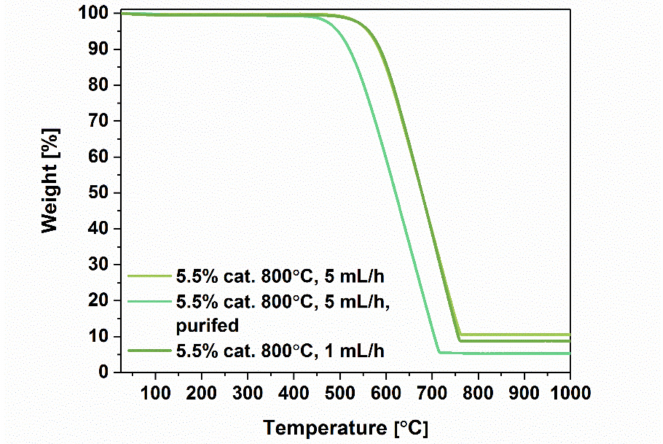
Figure 7. ComparisonofthermogramsofMWCNTsobtainedwithdifferentinjectionspeedandafterpurification.